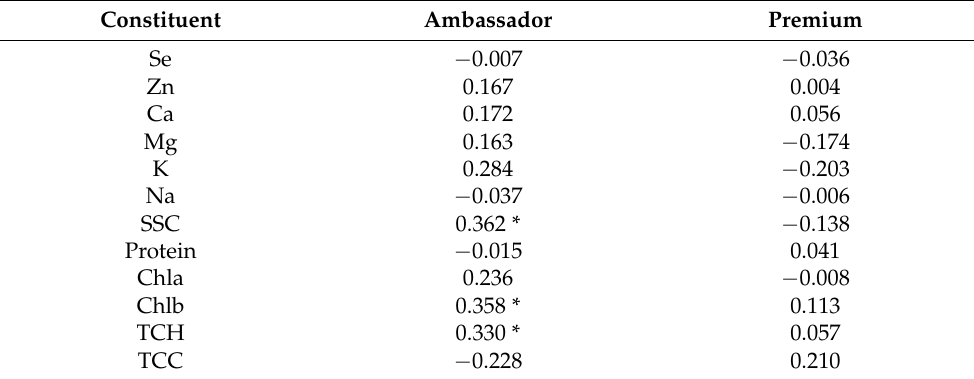
Table 5. Pearson correlation coefficients between the concentrations of total condensed tannins and minerals, macronutrients and bioactive compounds evaluated for seeds of two pea varieties (Ambassador and Premium).